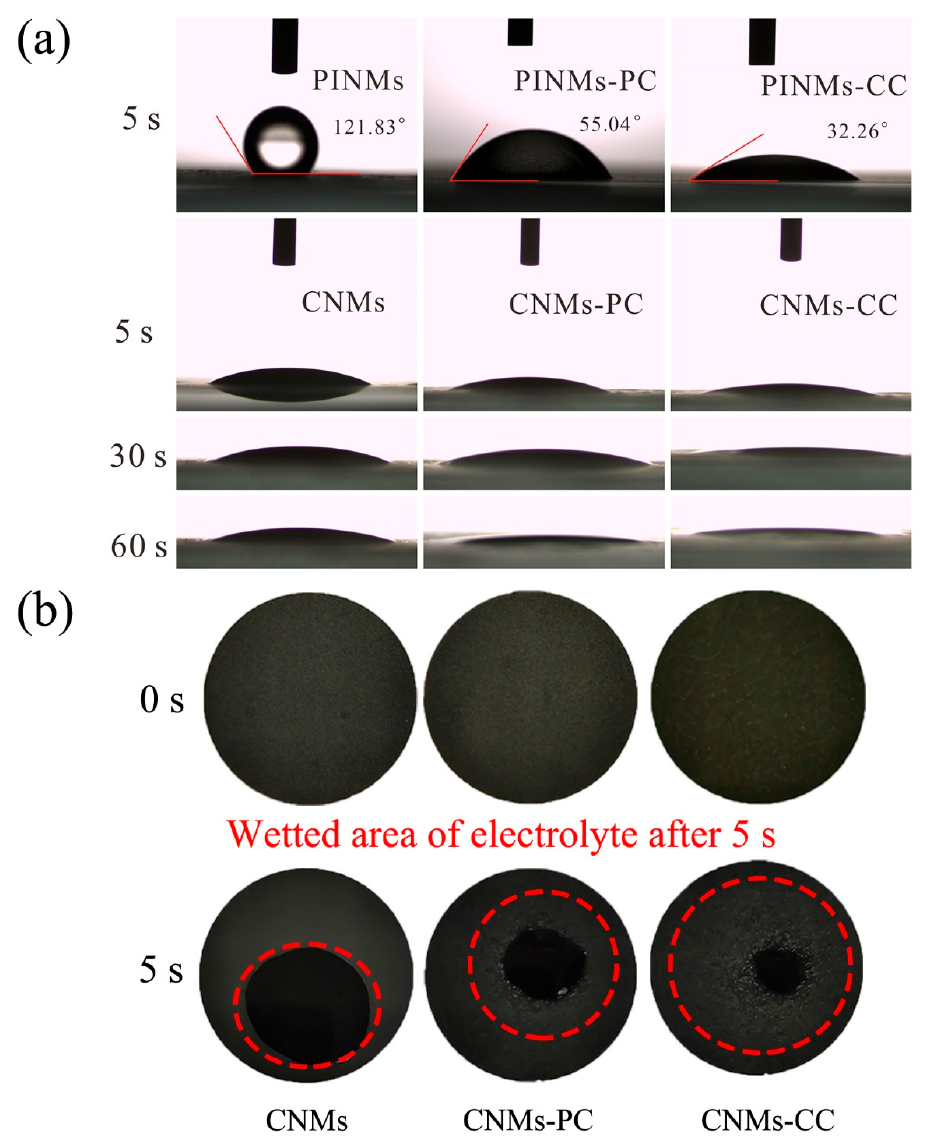
Figure 7. ( a ) Contact angle determination of PINMs, PINMs-PC, PINMs-CC, CNMs, CNMs-PC and CNMs-CC and ( b ) photographs of electrolyte wettability for CNMs, CNMs-PC and CNMs-CC.